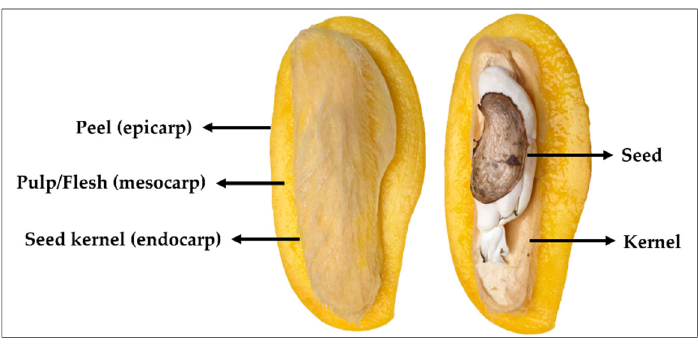
Figure 1. The biomass composition of mango fruit. Table 1. Physical characteristics of different ripe mango varieties.